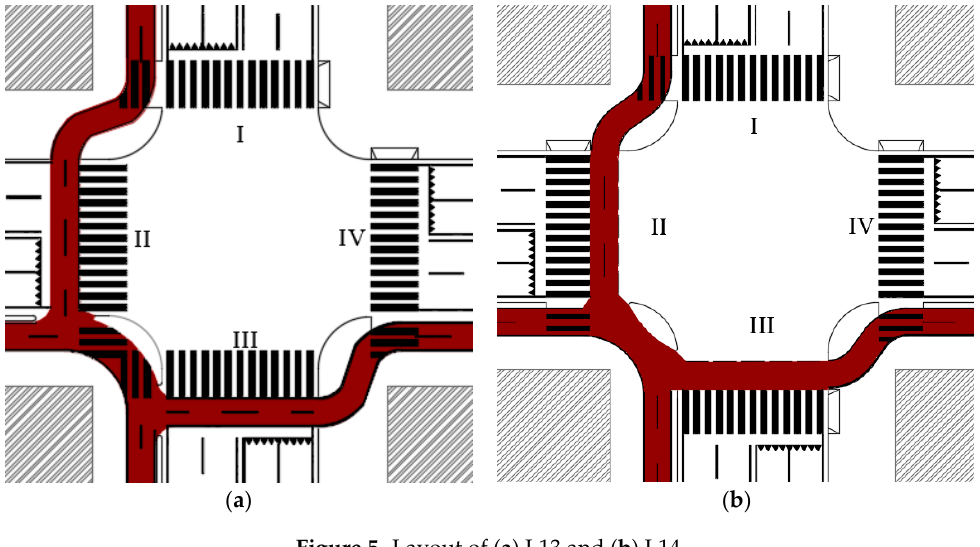
Figure 5. Layout of ( a ) L13 and ( b ) L14.